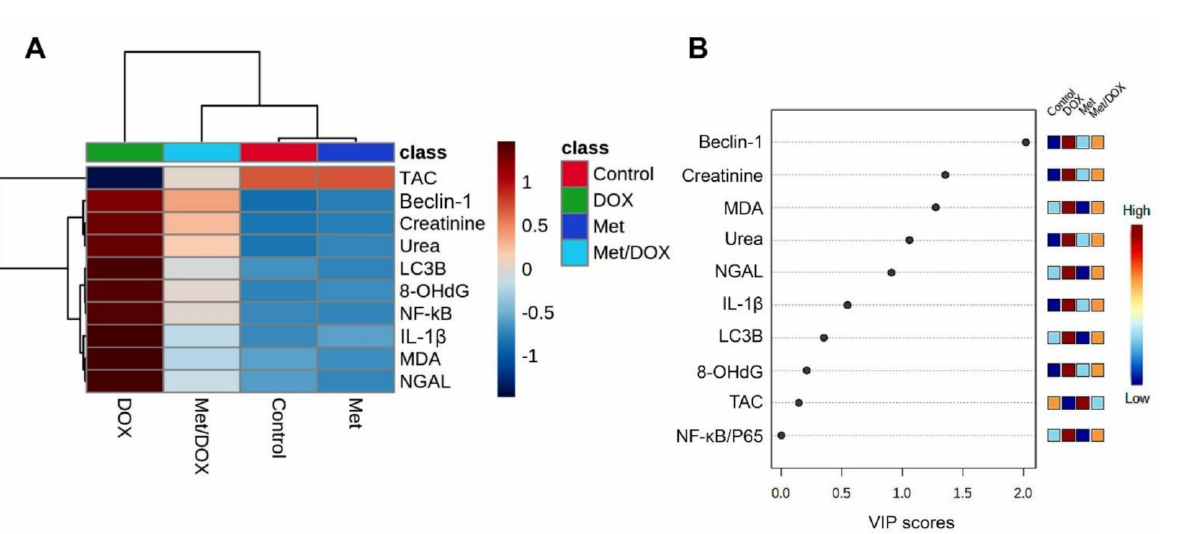
Figure 7. Prophylactic effect of Met on renal LC3B and Beclin-1 expression levels. The figure shows the protein expression of LC3B by immunostaining in control ( A ), Met ( B ), DOX ( C ), and DOX/Met ( D ) groups (arrows indicate the positive stained area; bars = 50 µ m). ( E ) Bar-dot plot of the semi-quantitative analysis of LC3B expression levels in renal tissue obtained by immunostaining. ( F ) Bar-dot plot of the renal concentration of Beclin-1 after Met and/or DOX treatments. Student’s t -test was used for statistical comparisons. Data are expressed as mean ± SEM. Colored dots indicate each individual value and colored curves represent the distribution of each data point. *** p < 0.001 vs. control group and ## p < 0.01 vs. DOX group.